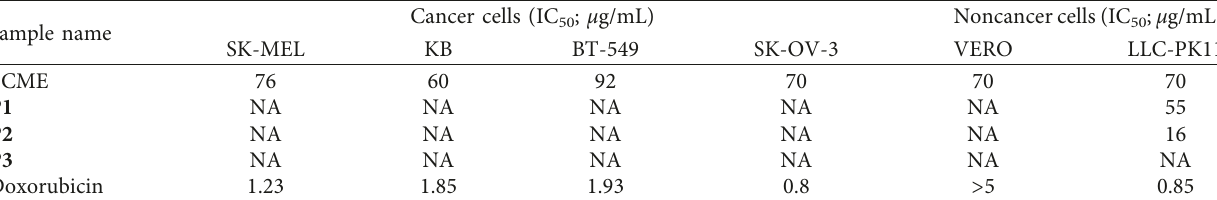
Table 3: Cytotoxicity of PCME and P1 , P2 , and P3 .